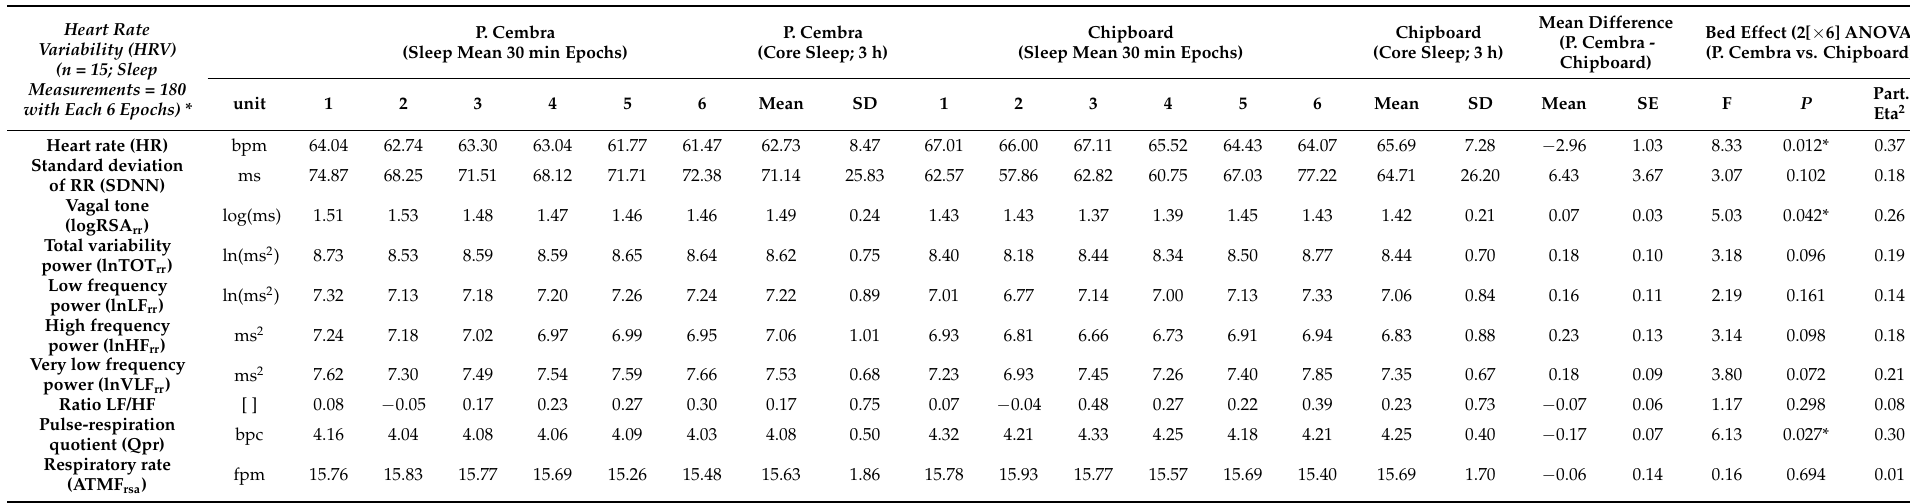
Table 2. HRV—core sleep in different bed materials.